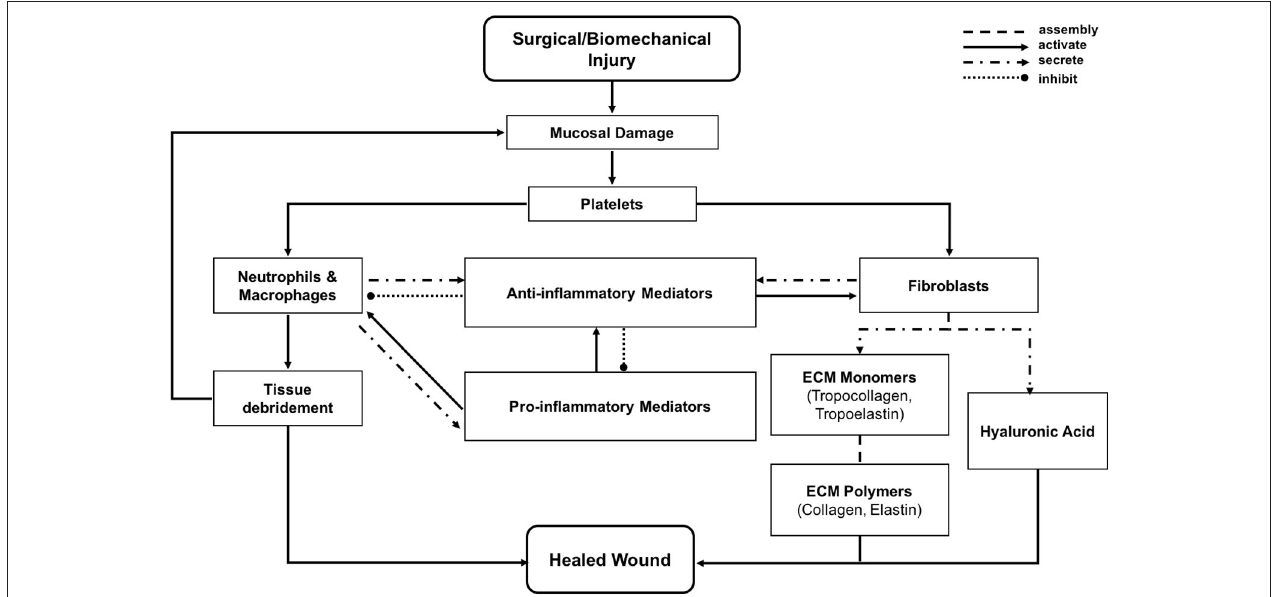
FIGURE 1 | Flowchart of vocal fold inflammation and healing events in the ABM. This diagram is modified from Li et al. (2008).